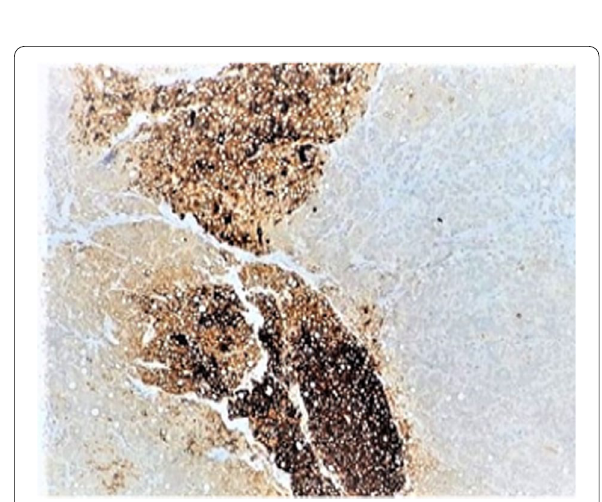
Fig. 2 Immunohistochemical marker PSA shows patchy strong positive staining of the tumour